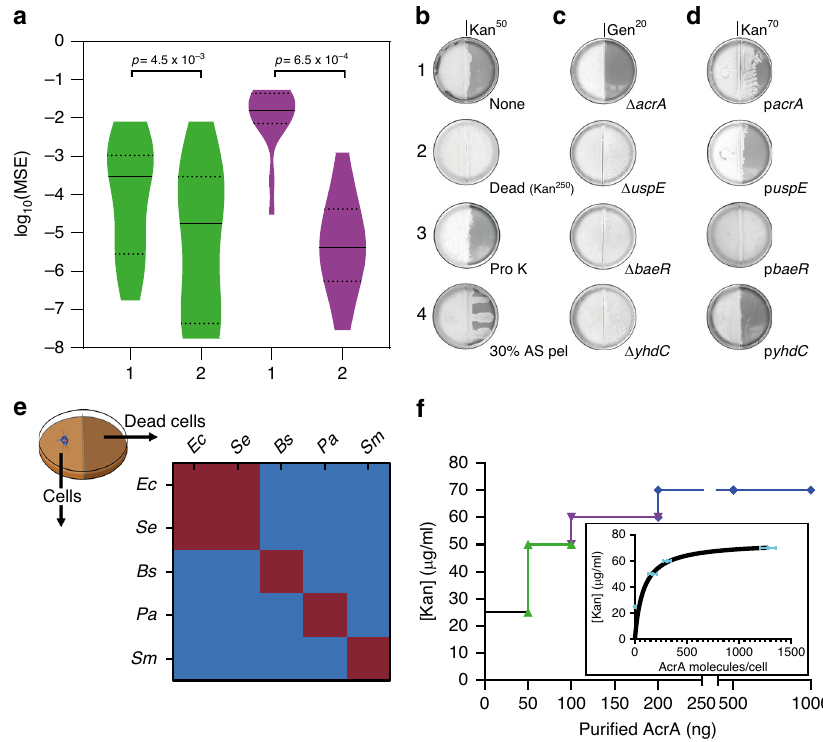
Fig. 1 Dead bacteria release a necrosignal. a Graph showing distribution of the mean squared errors (MSE) between experimental and simulated killing curves of planktonic (green) and swarm (purple) cells shown in Supplementary Fig. 1a; 1 and 2 are simulations assuming homogeneous and heterogeneous populations, respectively (see “ Methods ” ). The indicated p values were calculated from a two-tailed Wilcoxon rank sum test between the two types of populations. Median, solid black lines; quartiles, dashed black lines. b – d Border-crossing assays that established the identity of the necrosignal. WT E. coli were inoculated in the left chamber in every case, whereas material applied to the right chamber is indicated below each plate. b None, no cells applied; Dead (Kan 250 ), cells killed by Kan 250 ; Pro K, cell extract supernatant from killed cells, treated with Proteinase K (see Supplementary Fig. 2b for